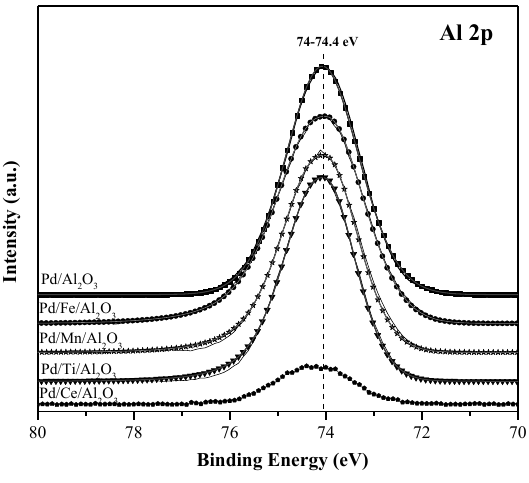
Figure 6. Al 2p XPS spectra of Pd/Al 2 O 3 and Pd-doped-Al 2 O 3